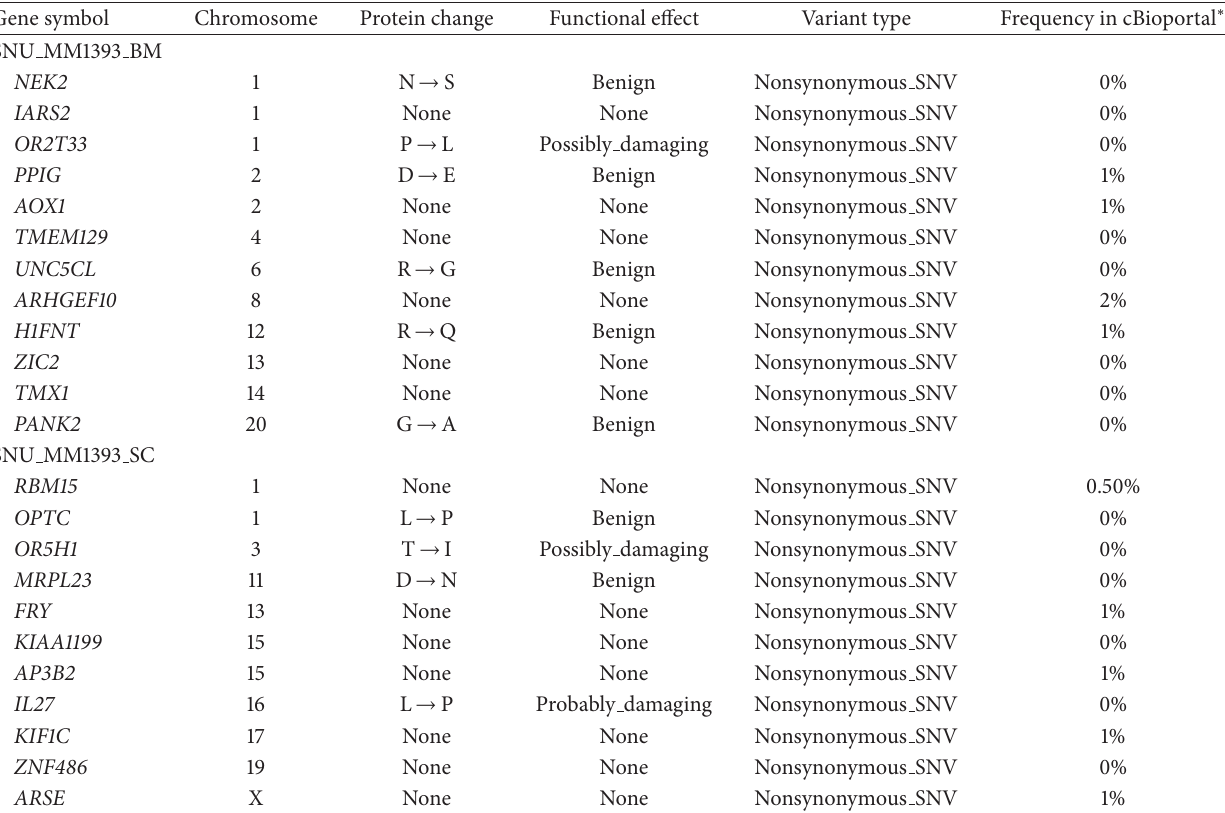
Table 1: Gene list of two cell